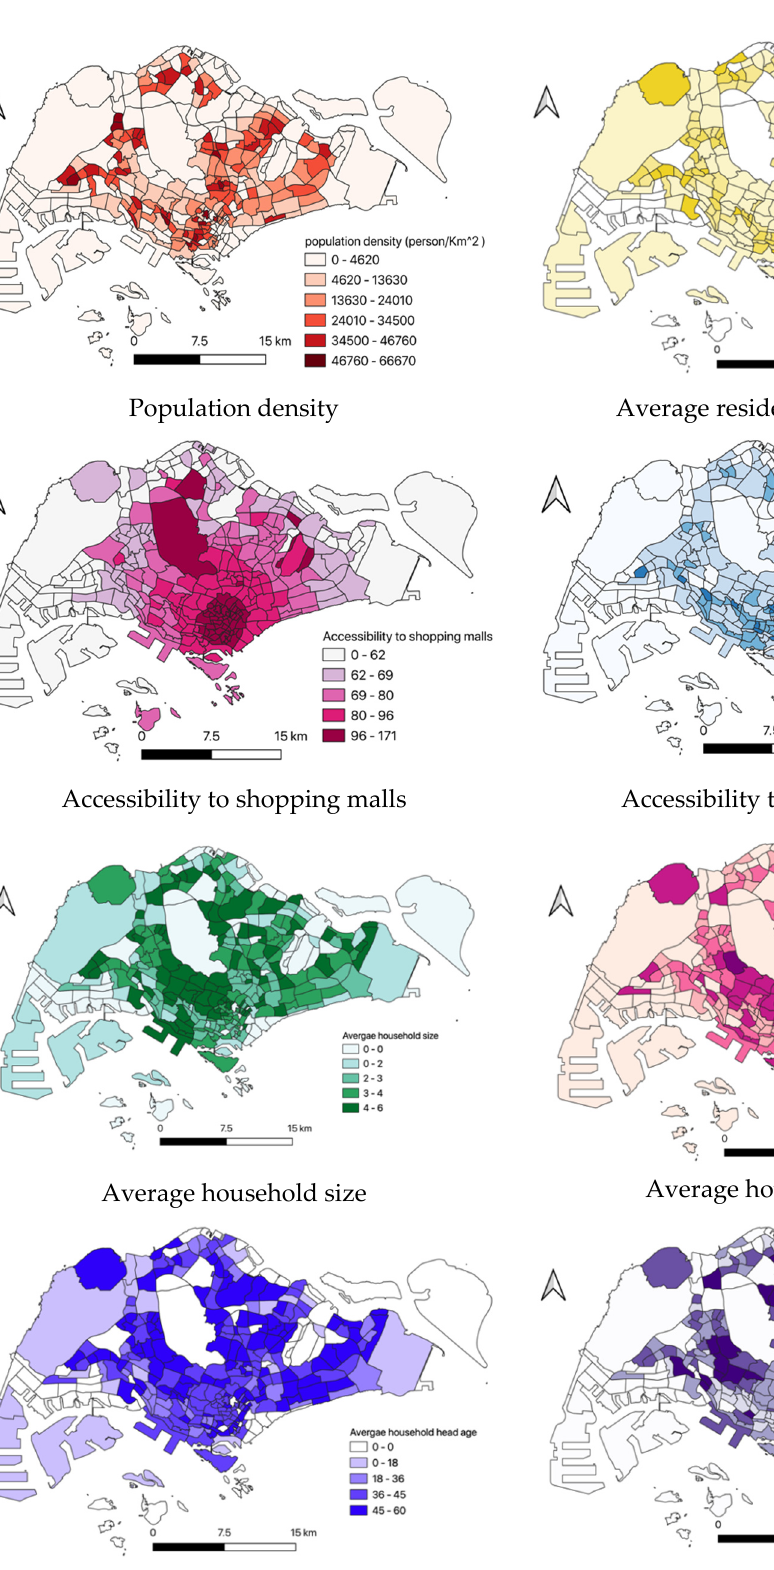
Figure 3. Spatial distributions of explanatory variables.